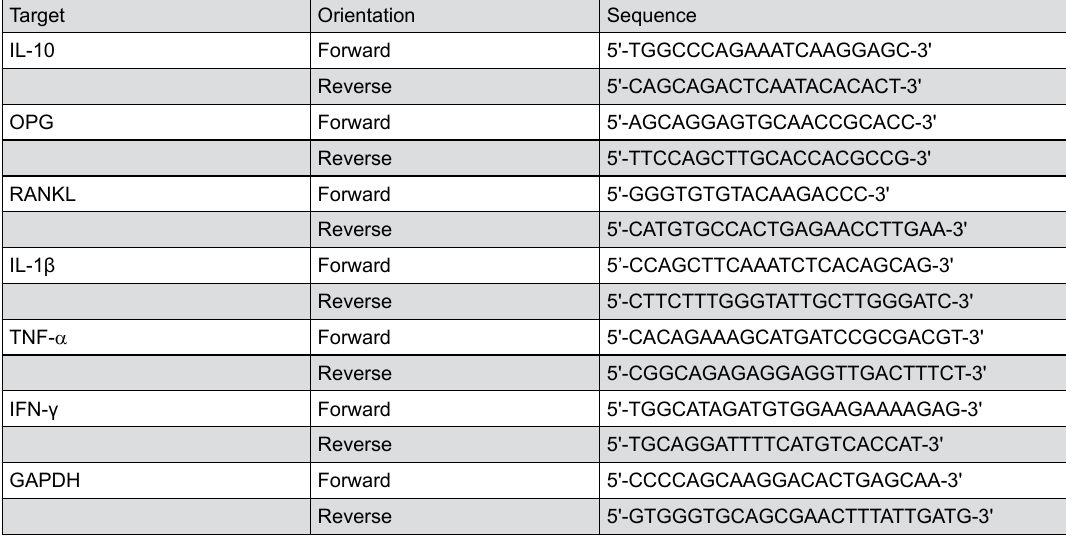
Figure 1- Primers and sequences used for qRT-PCR. Mouse IL-10, OPG, RANKL, IL-1β, TNF- α , IFN-γ and GAPDH primers for qRT-PCR are